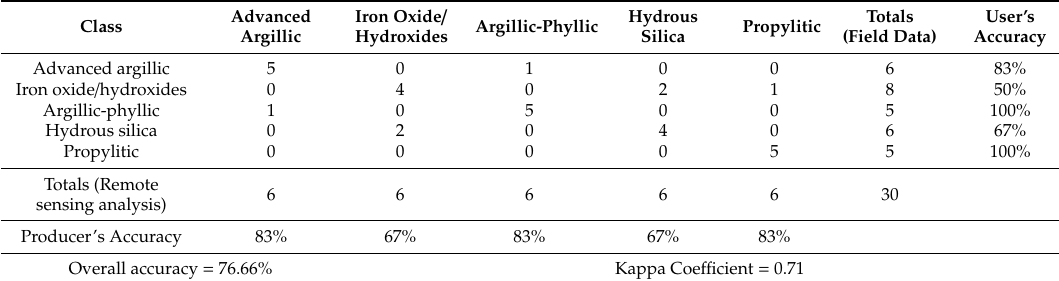
Table 7. Confusion matrix for alteration mineral mapping versus field